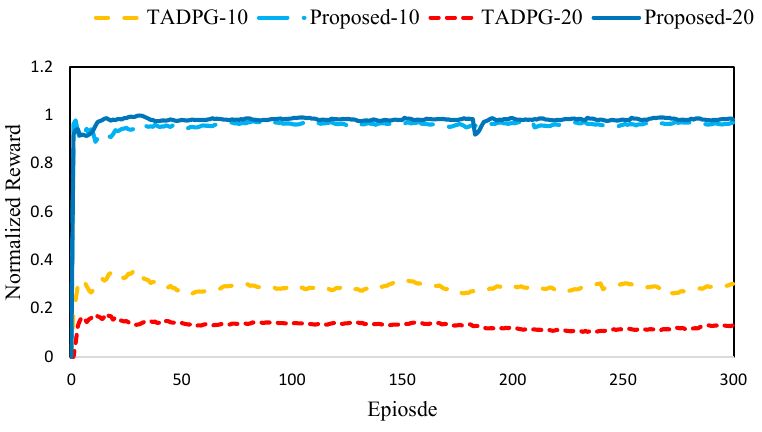
Figure 6. Reward variation comparison.